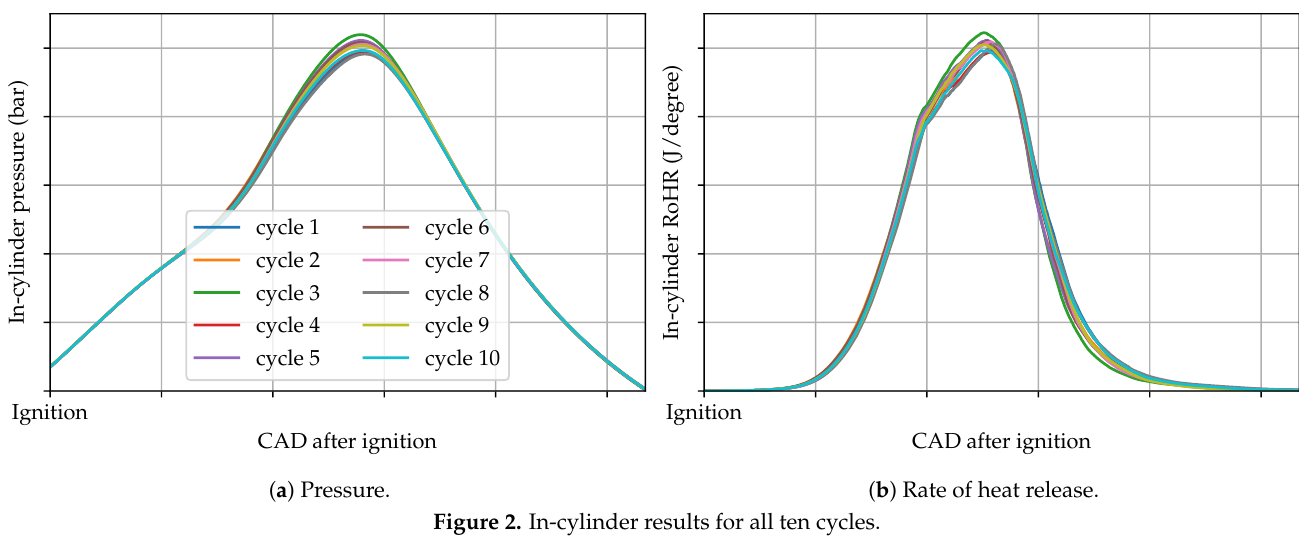
Figure 2. In-cylinder results for all ten